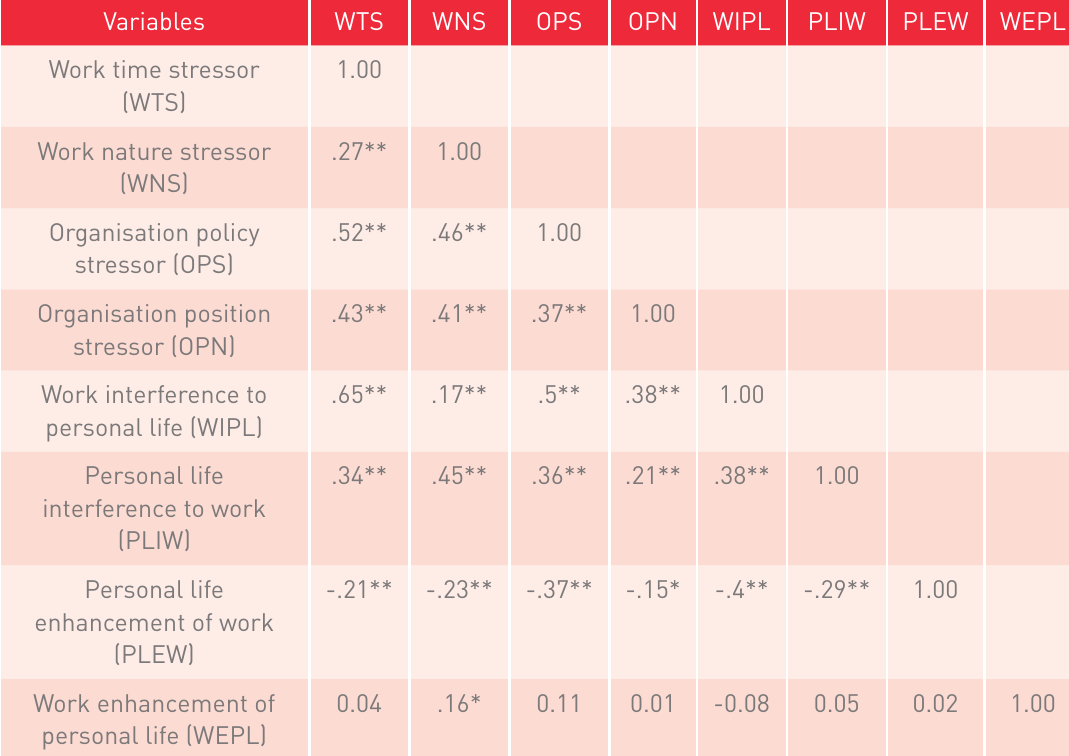
Bivariate correlation between the hypothesized variables